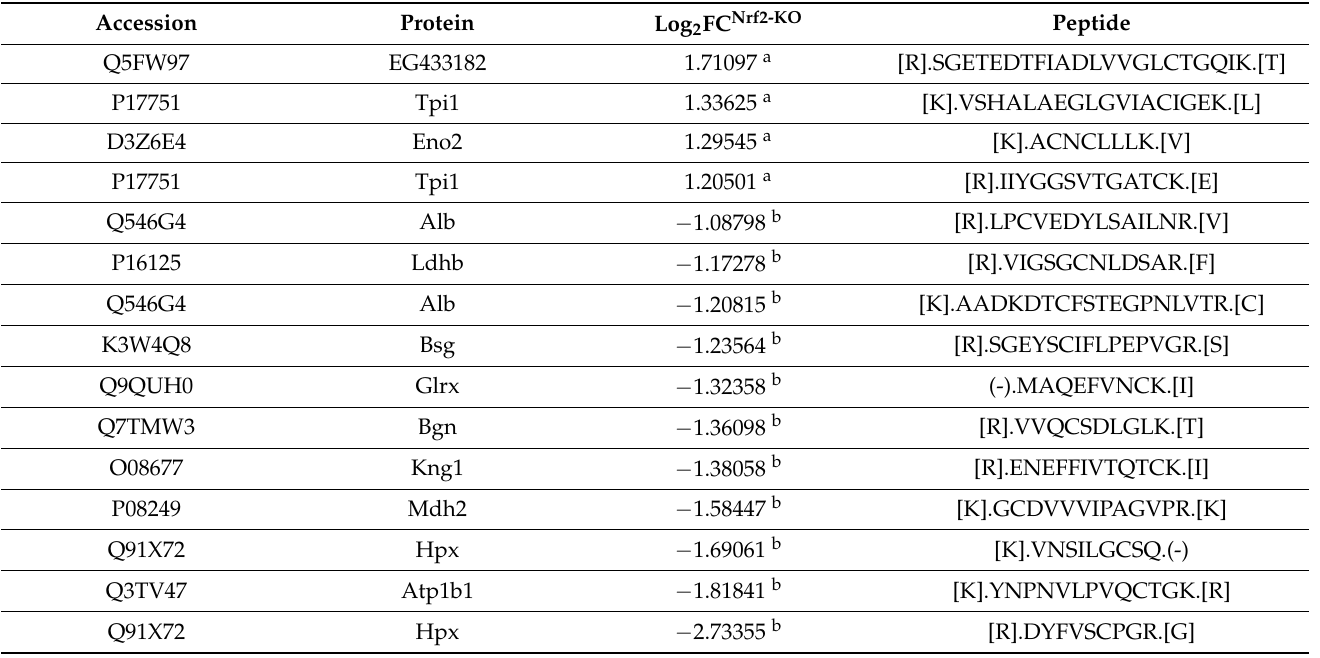
Table 2. List of significantly differentially expressed redox peptides in Nrf2-KO-deficient